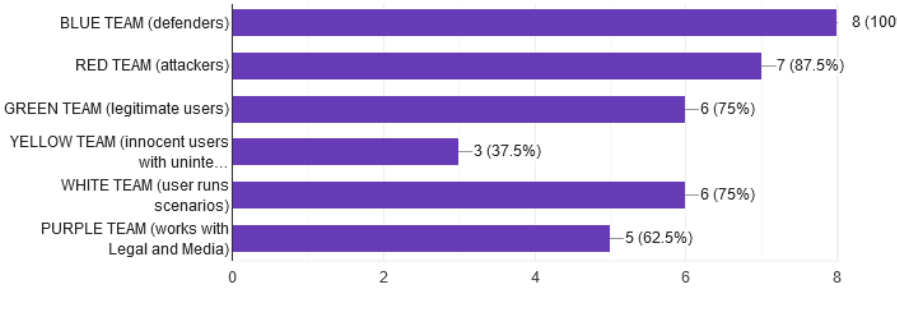
Figure 17. Cyber Security